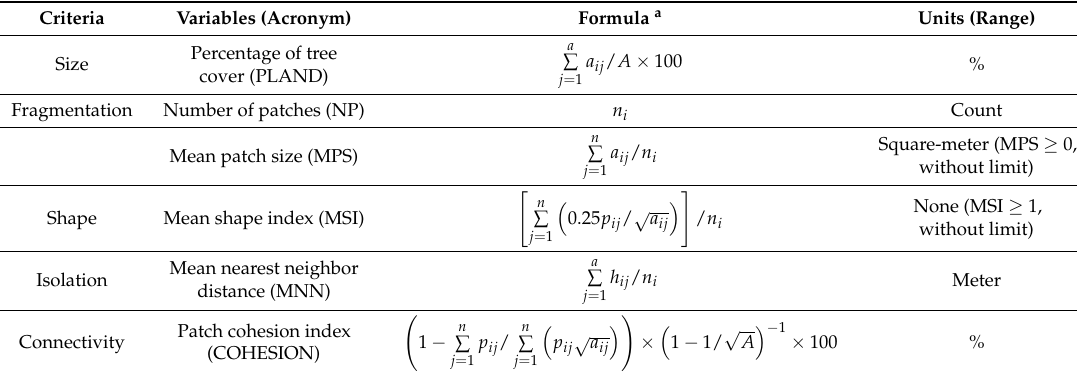
Table 1. Selected landscape indices, formulas, and